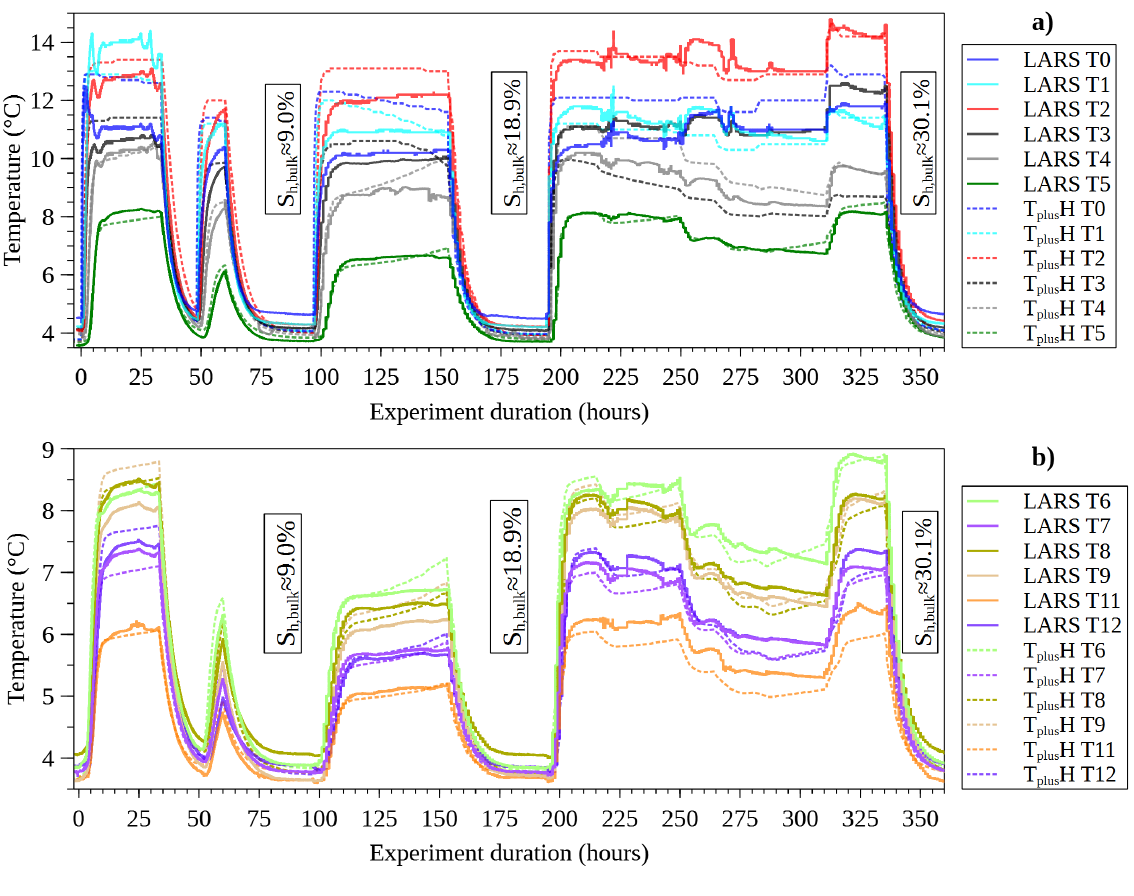
Figure 6. Observed and simulated temperature evolution during the 360-hour hydrate formation experiment at RTDs T0–T5 ( a ) together with T6–T9, T11, and T12; ( b ) based on the revised RTD locations (cf. Figure 5b and Table 5). LARS T0–T12 data were adapted from the CH 4 hydrate formation experiment conducted by Priegnitz et al.